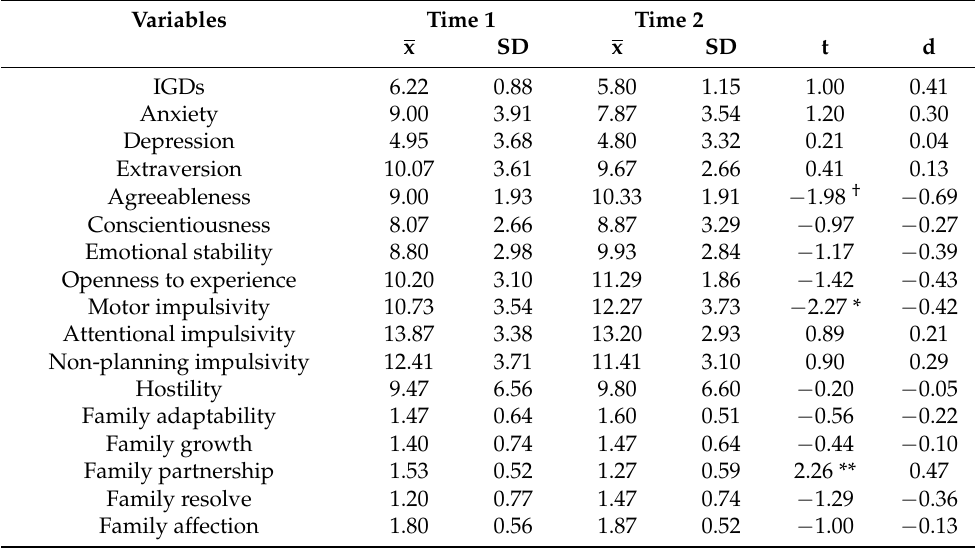
Table 4. Difference of means in the variables evaluated between T1 and T2 for the persistence